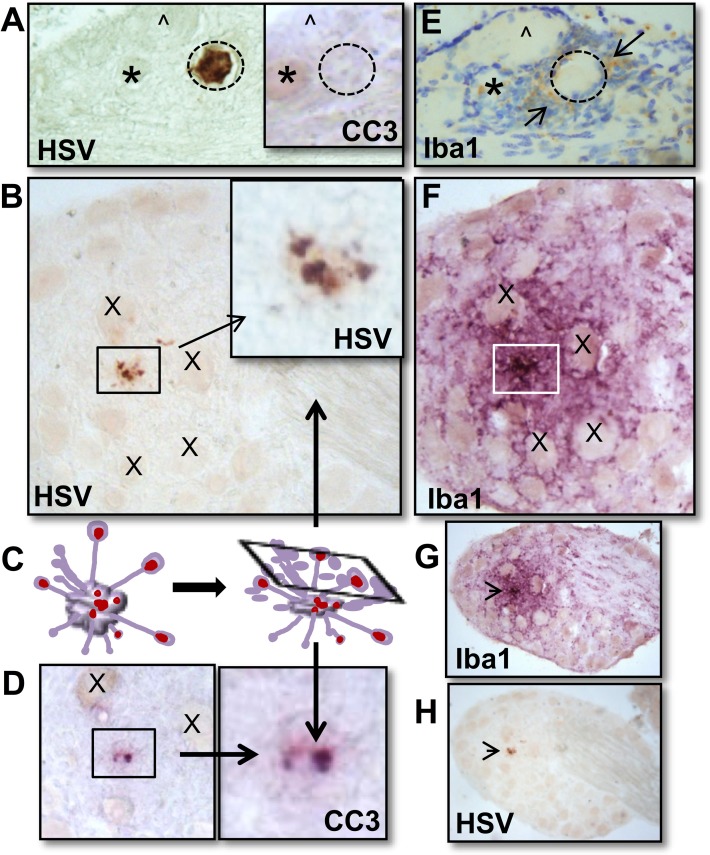
Colocalization of cleaved caspase-3 with fragmented HSV+ neurons, but not intact HSV+ neurons.Latently infected mice (n = 6; n = 5) were subjected to hyperthermic stress and ganglia were harvested 34 h phs. All ganglia were directly fixed in 4% formaldehyde, embedded, sectioned, and serial sections were assayed for HSV, cleaved caspase-3, or Iba1 expression as described in Methods. (A) Intact HSV positive (DAB; brown) neuron detected in sectioned material did not express cleaved caspase-3 (cc3). A serial section revealed few Iba1+ (brown) cells surrounding the intact neuron undergoing reactivation (cresyl violet counterstain). (*) and (^) mark the same neurons in each section to provide orientation. (B) Fragmented HSV positive (brown) neuron shown at a higher magnification in the box. This neuron was surrounded by extensive Iba1+ microglia (VIP; purple). (X) marks nearby neurons to provide orientation. A lower magnification view of both sections is provided with an arrow indicating the HSV positive fragmented neuron. (C) Pictorial representation of a neuron undergoing apoptosis and characteristic membrane protrusions. The rectangle represents a cross section through this cell that corresponds with the observed cellular fragments in (B and D). (D) A serial section of the fragmented HSV positive neuron in ‘B’ was found to express cc3 (VIP; purple). A higher magnification of the boxed area is shown. (X) marks the same neurons shown in ‘B’. (E) A serial section of the intact HSV positive neuron in ‘A’ was found to have some Iba1+ cells (brown) present in the surrounding inflammatory cuff following counterstaining with cresyl violet. (F) A serial section of the fragmented HSV positive neuron in ‘B’ was found to have many Iba1+ cells (VIP; purple) present in the surrounding inflammatory cuff. (G) A lower power view of ‘F’ and (H) a lower power view of ‘B’ demonstrate the localized specificity of reactivation and the formation of the inflammatory cuff in the ganglia.